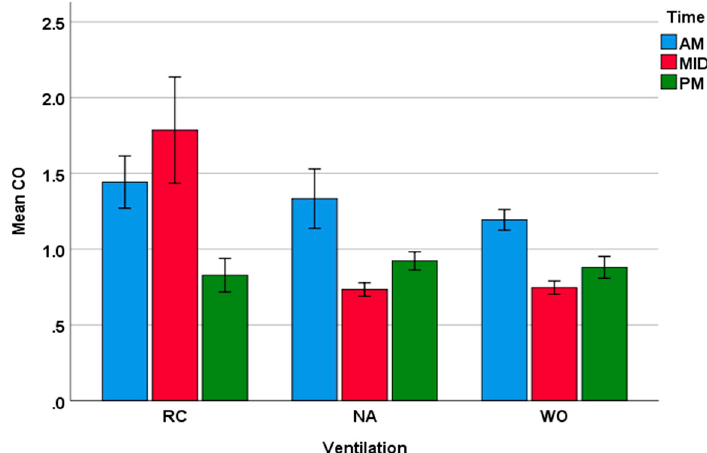
Figure 6. Bar graph showing the loop mean concentrations for each of the periods of monitoring sorted by season. The error bars represent one standard error of the mean ( N = 3).